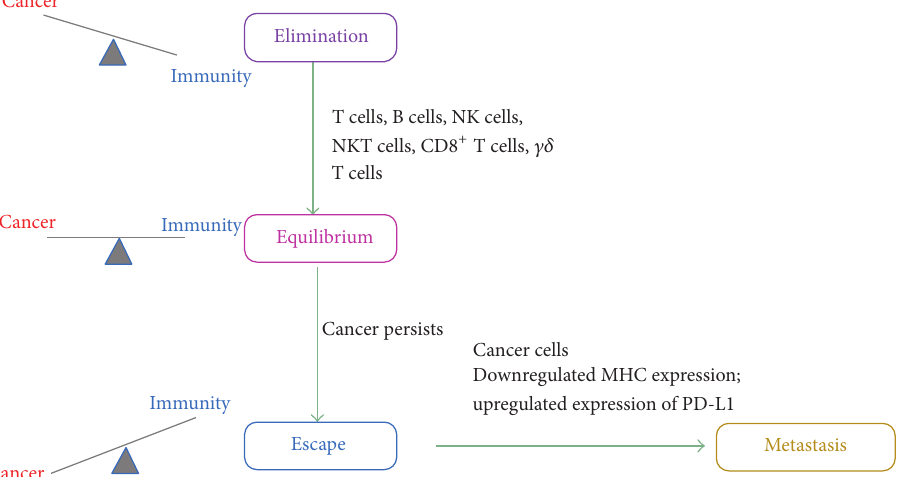
Figure 2: The cancer immunoediting process. There are three phases in the cancer immunoediting process: elimination, equilibrium, and escape [4]. Elimination phase involves effector function of the immune cells to target and eradicate cancer. In the equilibrium phase a balance is obtained between progression of cancer and cancer elimination by the immune system. If the cancer persists then it overwhelms the immunity and escapes to go on and metastasize to the other organs [4, 40,